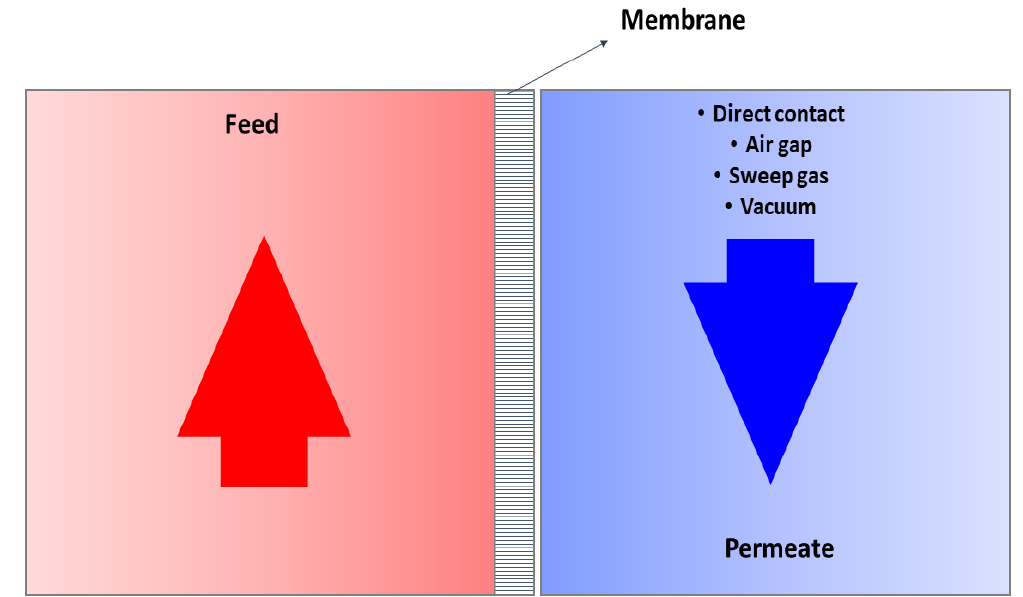
Figure 2. Schematic of the MD